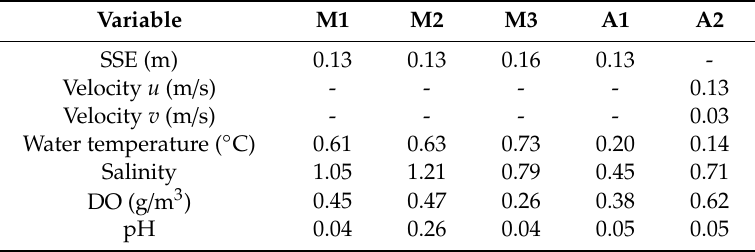
Figure 3. Observed and predicted SSE, current velocity (components u and v ), water temperature, salinity, DO, and pH for ( A1 ) and ( A2 ) stations located at Ria de Alvor on 25 October 2018. Table 2. Root mean square error (RMSE) for Mira estuary (M1, M2, M3) and Ria de Alvor (A1, A2)